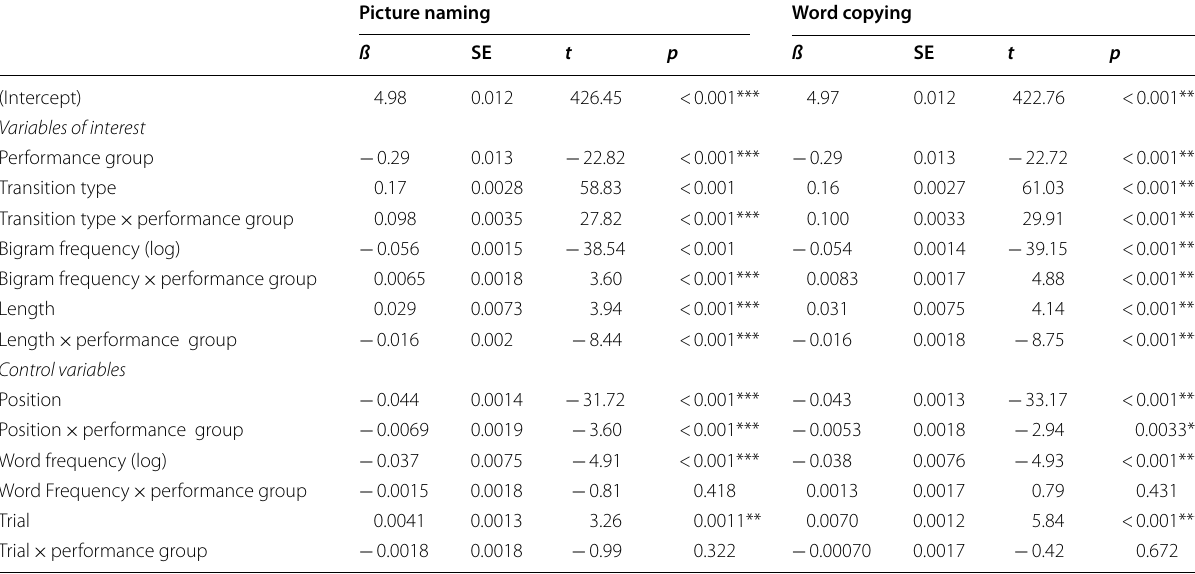
Table 3 Results of mixed‑effect model on IKI for the picture naming and word copying tasks Picture